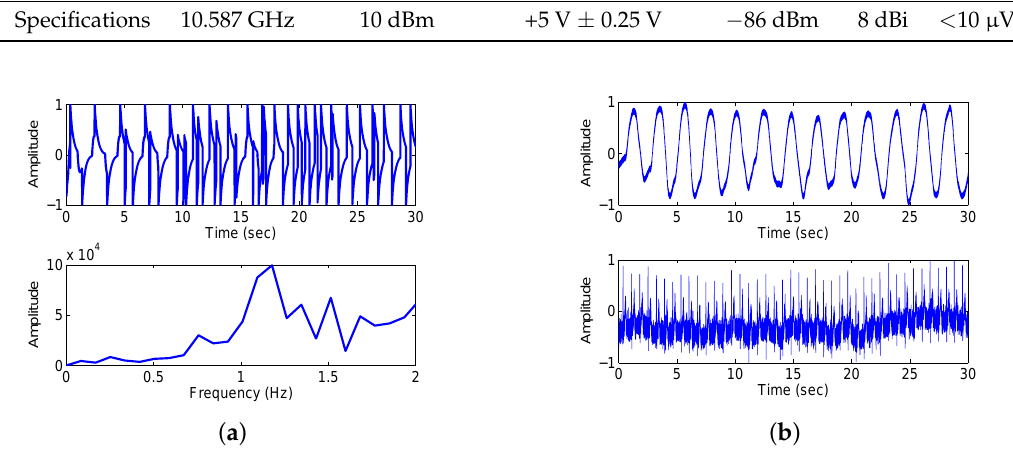
Figure 7. Doppler radar signal and reference signals ECG and RW. ( a ) Received radar signal ( top ) and power spectrum density (PSD) of the radar signal ( bottom ); ( b ) RW ( top ) and ECG ( bottom